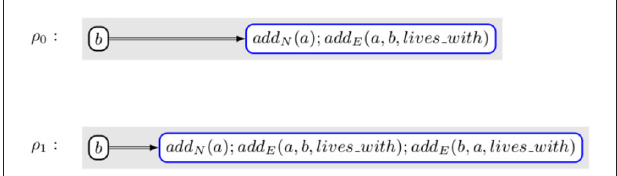
FIGURE 4 | Rules creating a new node a and connecting it via property lives _ with to the node b .